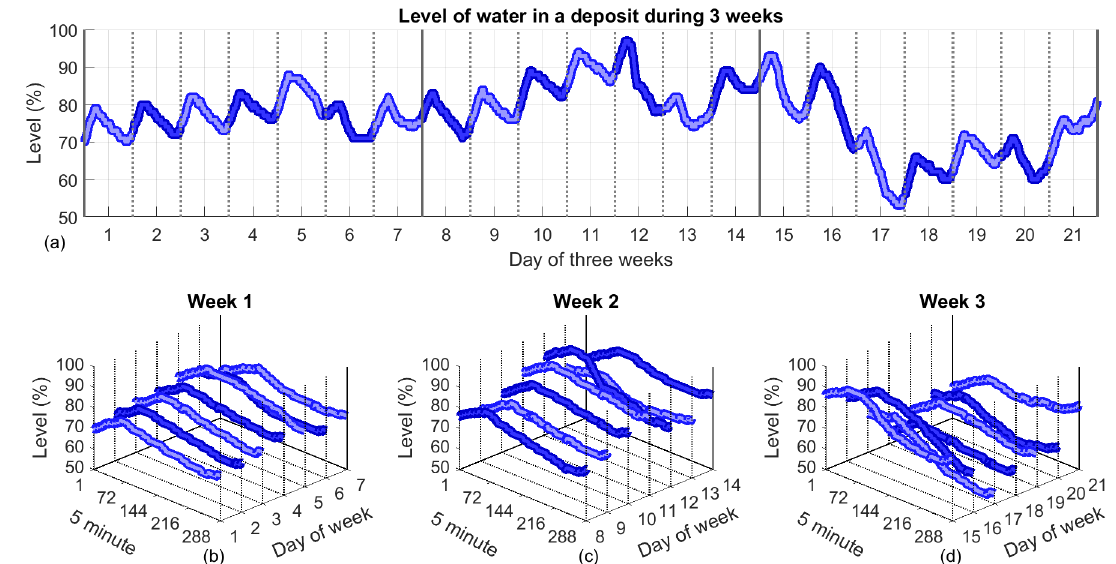
Figure 5. Representation of vector folding x , corresponding to the measurements of three weeks in a tensor χ 288 × 7 × 3 : ( a ) represents the signal x where the fine vertical lines denote the daily separation and the bold vertical lines show the weekly separation; ( b ) represents the information given in χ ( :, :,1 ) of week 1, in which each vector χ ( :, i ,1 ) , i ∈ [ 1,7 ] provides the daily measures of day i ; ( c ) shows the same representation for χ ( :, :,2 ) of week 2 and ( d ) for χ ( :, :,3 ) of week